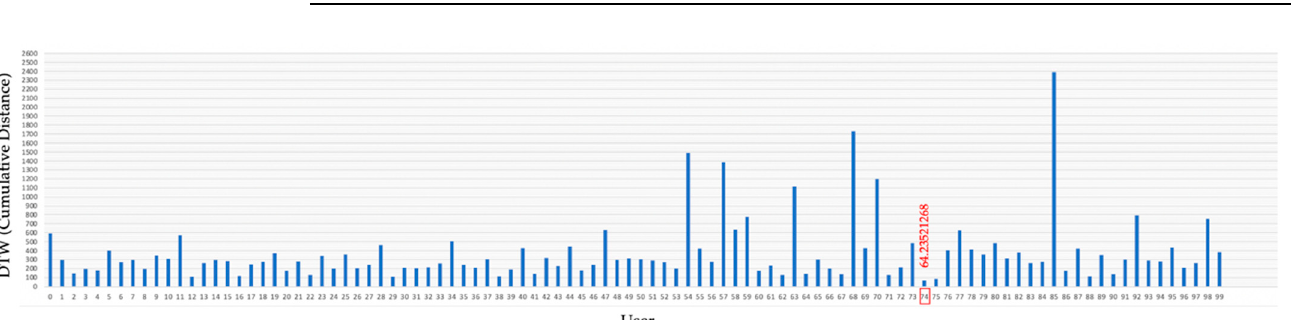
Figure 8. Minimum DTW normalized cumulative distances across sessions of each individual user.